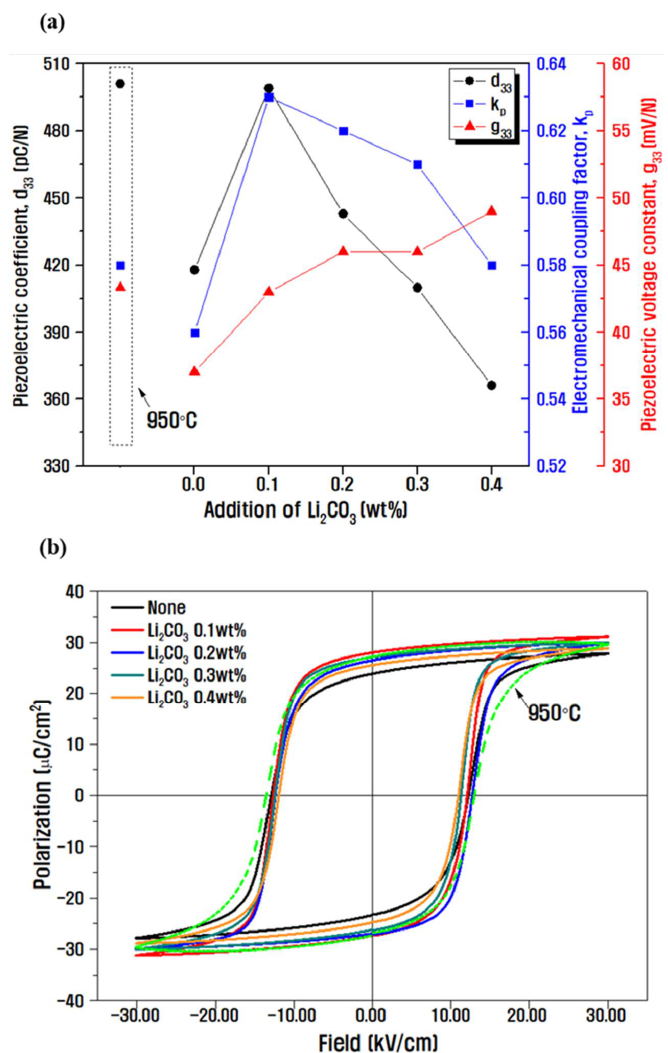
Figure 5. ( a ) Electric properties ( d 33 , k p , g 33 ) of specimens sintered at 875 ◦ C with varying amounts of the Li 2 CO 3 dopant, and ( b ) the corresponding P–E hysteresis loops. The sample sintered at 950 ◦ C without doping is represented by the data within dotted lines in ( a ) and the green, dashed profile in ( b ).